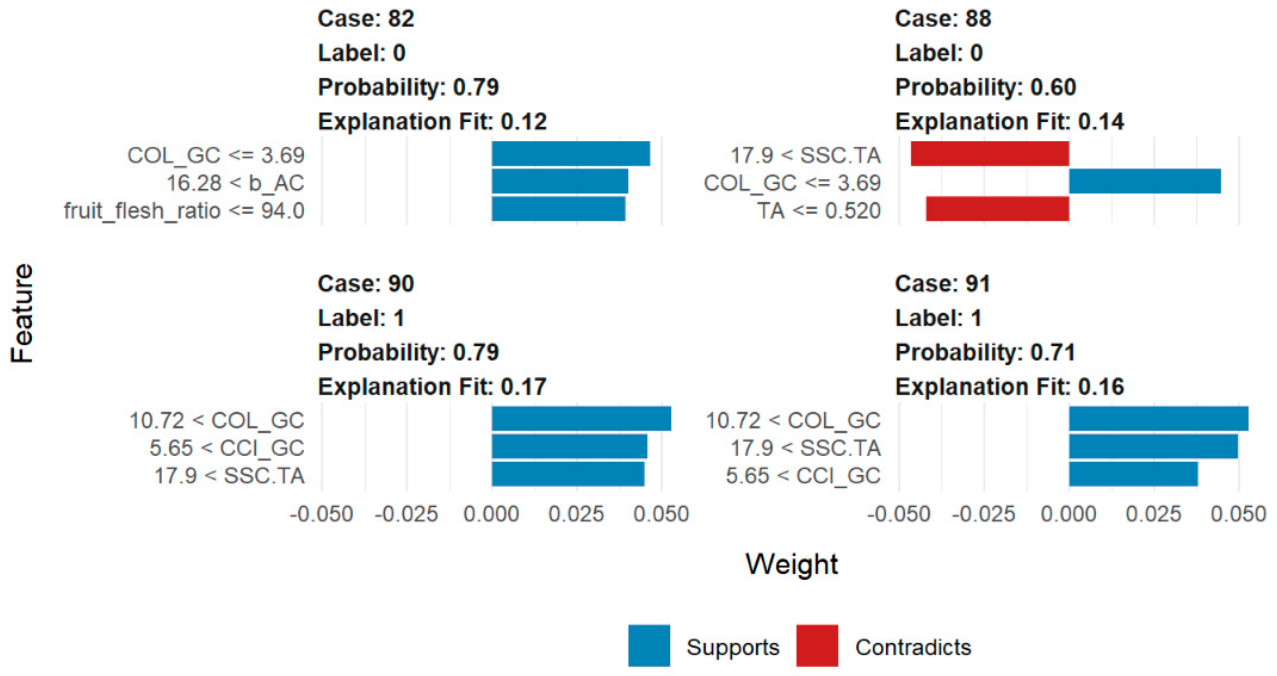
Figure 6. Several random samples of the LIME method on the Model C dataset. (Due to the inability to use special characters in the programming language, feature names are slightly modified, as described in Appendix A . )